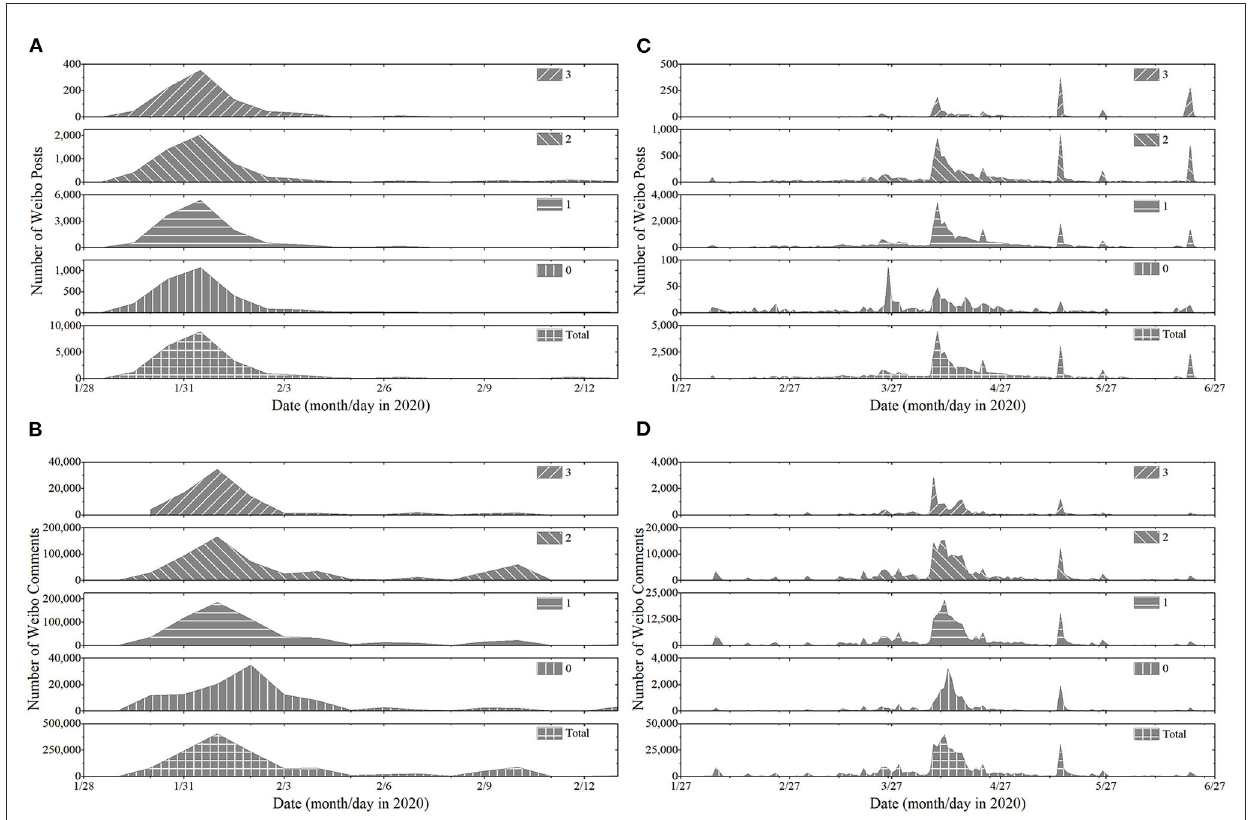
FIGURE3 The time series of different public sentiments of “The Wuhan Red Cross” and “Fangfang Diary”. (A) Posts sentiments of “The Wuhan Red Cross”. (B) Audience sentiments of “The Wuhan Red Cross”. (C) Posts sentiments of “Fangfang Diary”. (D) Audience sentiments of “Fangfang Diary”.